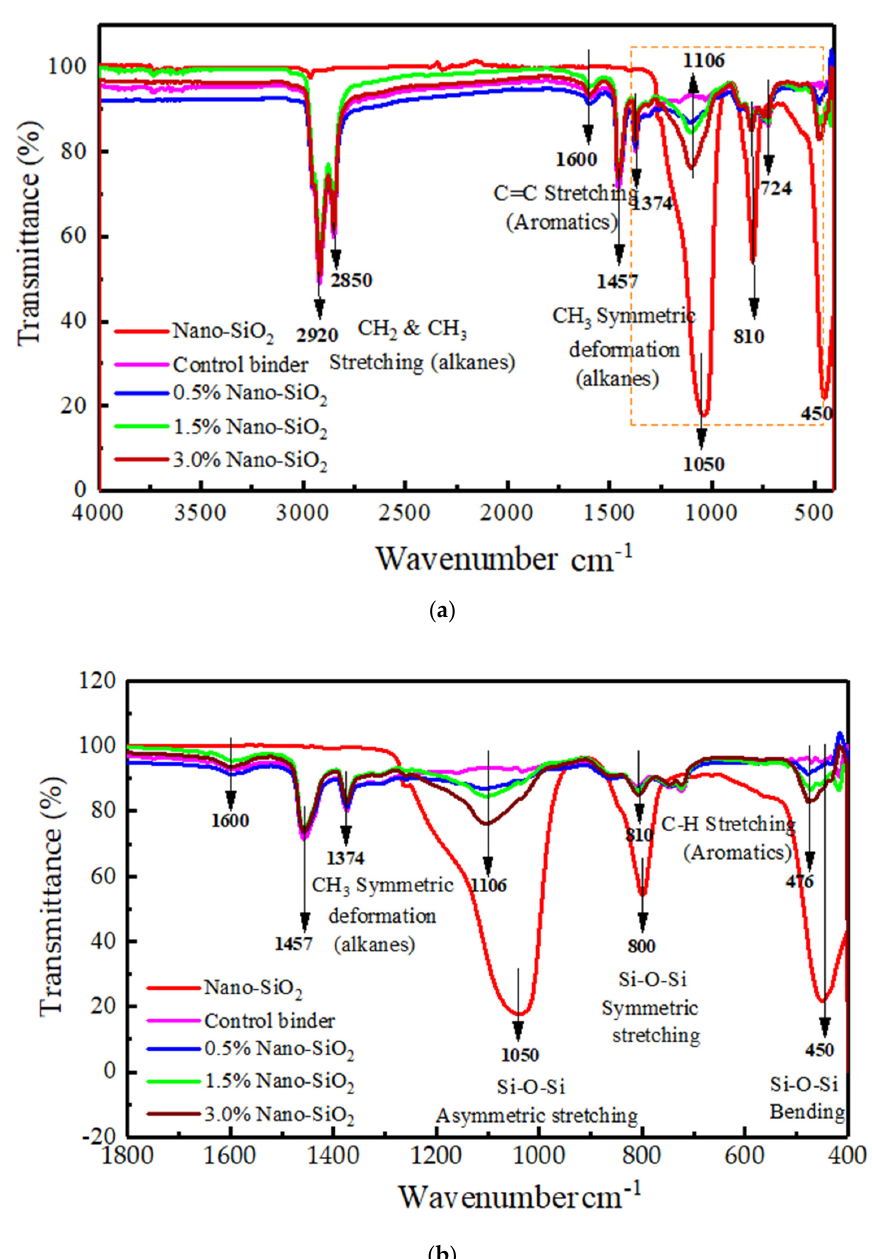
Figure 6. FTIR spectra of crumb rubber/nano silica composite pavement: ( a ) all functional groups, ( b ) detailed finger printing region.